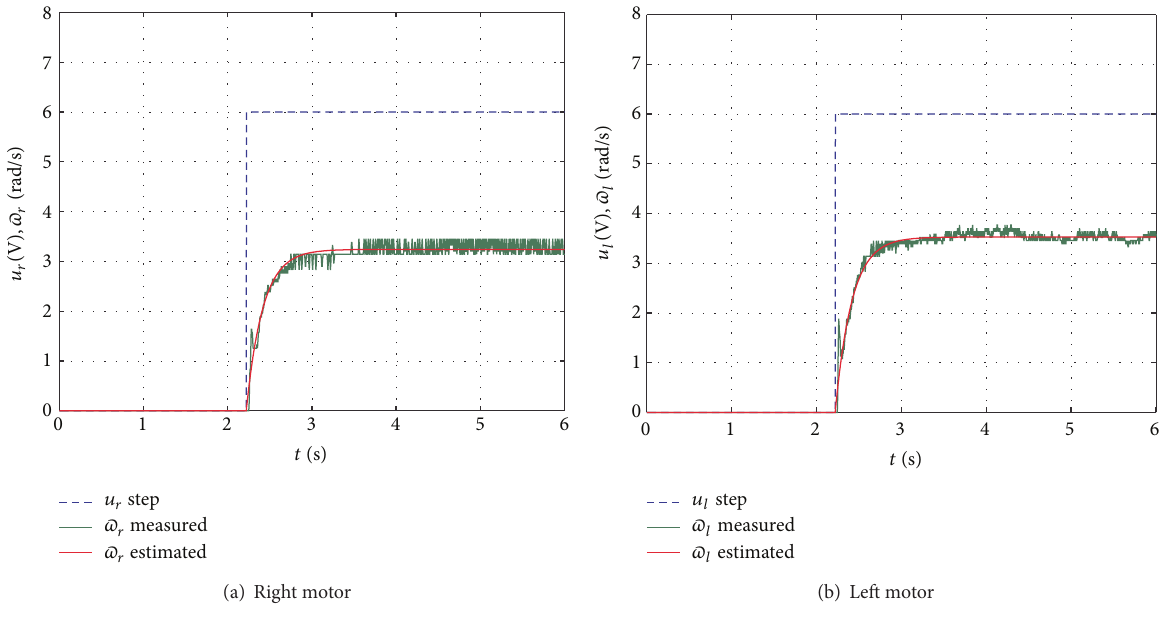
Figure 13: Step input response 𝑢 𝑟 (𝑡) = 𝑢 𝑙 (𝑡) = 6